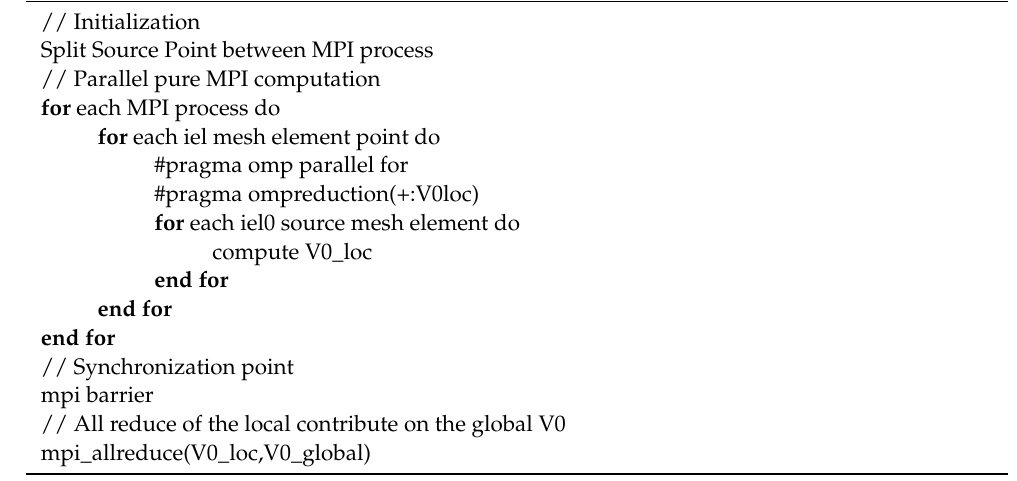
Algorithm 4 Evaluation of V0 , hybrid OpenMP-MPI Approach